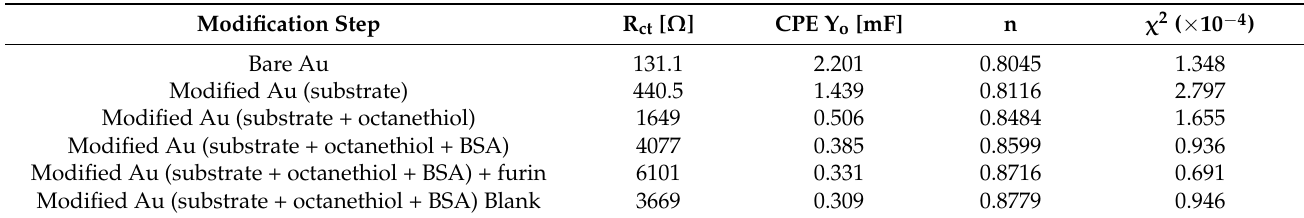
Table 1. Electrochemical impedance spectroscopy (EIS) characteristic parameters of gold electrodes—bare and